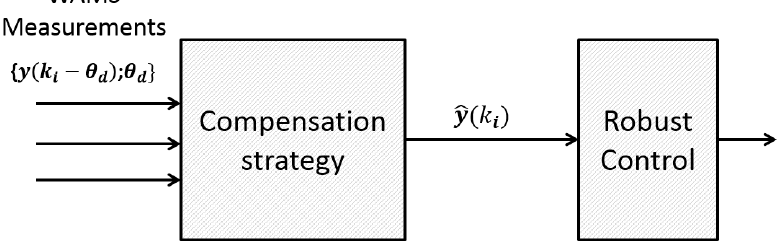
Figure 2. The Enhanced Time-Delay Compensator